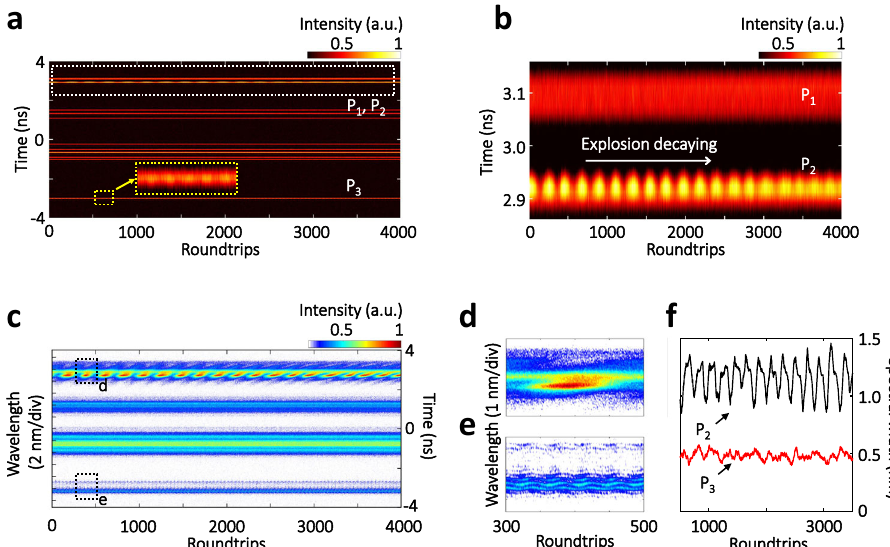
Fig. 6 Spectral-temporal explosion of 3D dissipative solitons. a Temporal evolution of the multipulse cluster. Inset shows the close-up of P 3 . b Close-ups of the temporal evolutions of P 1 and P 2 , as indicated by the white dotted rectangle in a . c Corresponding spectral evolution. d , e Close-ups of the spectral evolutions, as predicated in c . f Spectral width variations of P 2 and P 3